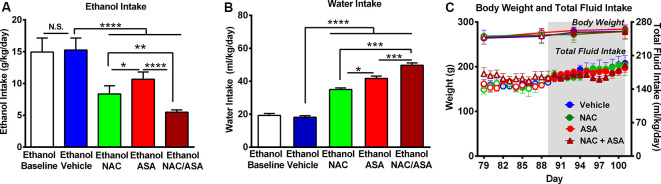
Administration of N-acetylcysteine (NAC; 40 mg/kg per day p.o.) + acetylsalicylic acid (ASA; 15 mg/kg per day p.o.) marked reduced ethanol intake in rats that had chronically consumed ethanol. (A) Significant inhibition of chronic alcohol intake following the oral administration of NAC or ASA vs. vehicle group [one-way analysis of variance (ANOVA): F4, 25 = 46.53, ****P < 0.0001; Tukey post hoc: vehicle-treated vs. NAC-treated and vs. ASA-treated groups, ****P < 0.0001, n = 6 rats per group]. Inhibition of ethanol intake was further increased by the coadministration of NAC + ASA when compared with either NAC or ASA group (**P < 0.01, NAC + ASA–treated vs. NAC- treated group; ****P < 0.0001, NAC + ASA–treated vs. ASA-treated group). Bars represent mean ± SEM of 11 consecutive days of ethanol intake, during which rats received by oral gavage NAC, ASA, NAC + ASA, or vehicle (from day 91 to day 101 of ethanol intake). Chronic ethanol intake of all groups (10-day baseline) prior to vehicle administration (mean ± SEM, 15.0 ± 0.9 g ethanol/kg per day) was not different from that of rats that received vehicle (mean ± SEM, 15.3 ± 0.8 g ethanol/kg per day; A: white bar vs. blue bar). Additionally, we found no significant differences between the baseline ethanol intakes of the four groups prior to drug/vehicle treatment [mean ± SEM, 15.0 ± 0.80 (ethanol vehicle); 14.0 ± 1.4 (ethanol NAC); 14.0 ± 0.2 (ethanol ASA); and 14.0 ± 0.7 (ethanol NAC + ASA) g ethanol/kg per day, n = 6/group; ANOVA: F3, 20 = 0.2968, P: N.S.] (B) NAC, ASA, NAC + ASA markedly increased water intake compared with the control (ethanol vehicle) and baseline group (ANOVA: F4, 25 = 132.5, P < 0.0001). (C) The administration of NAC, ASA, or the combination of NAC and ASA did not affect total fluid intake (ANOVA: F3, 48 = 1.406, P: N.S.) or body weight- (ANOVA: F3, 12 = 0.416, P: N.S) compared with vehicle administration. *P < 0.05 means significant difference between Ethanol NAC and Ethanol ASA groups. ***P < 0.001 means significant differences between Ethanol NAC/ASA with Ethanol NAC and Ethanol ASA groups. N.S., not statistically significant.